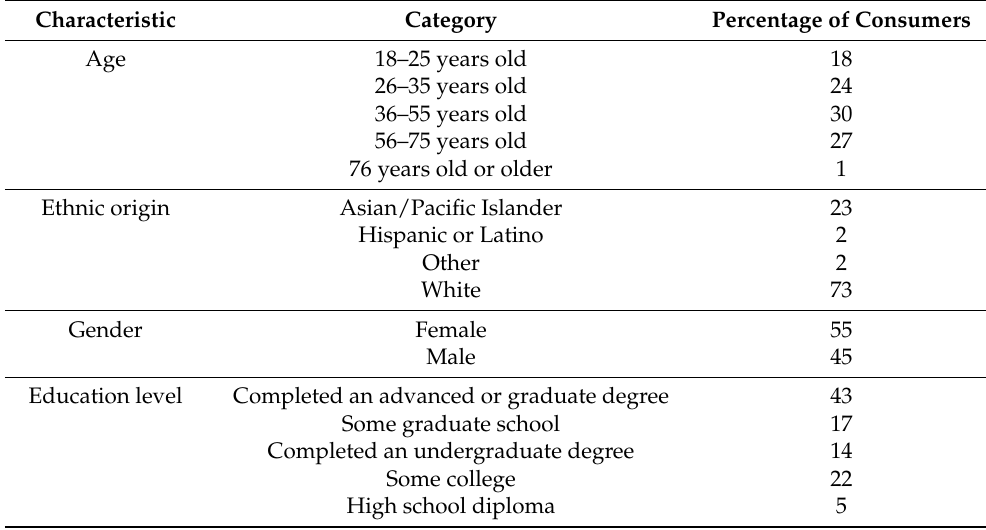
Table 2. Demographic summary of participants (133 total) evaluating the effects of cooking method and degree of doneness of boneless pork